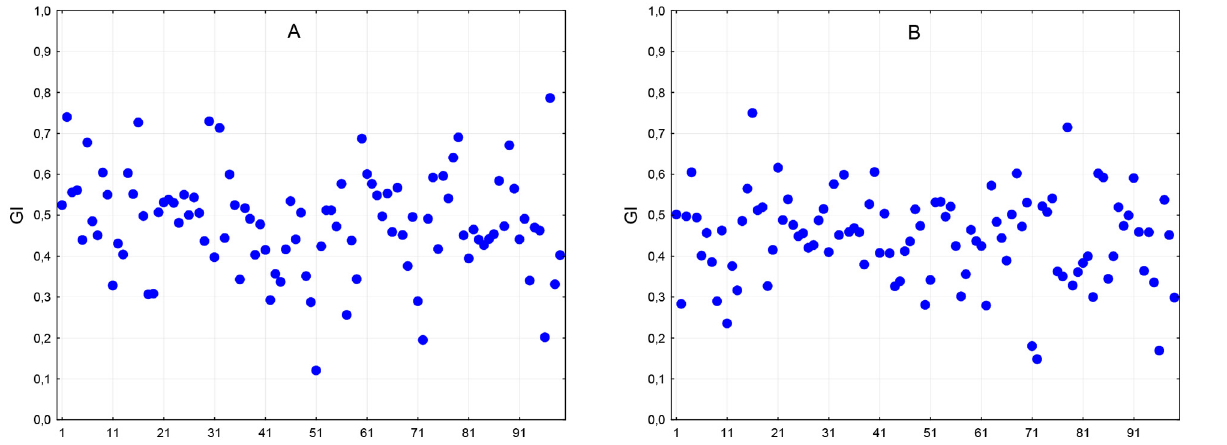
Fig 3. Guzik ’ s indexes for the rest session (panel A) and exam session (panel